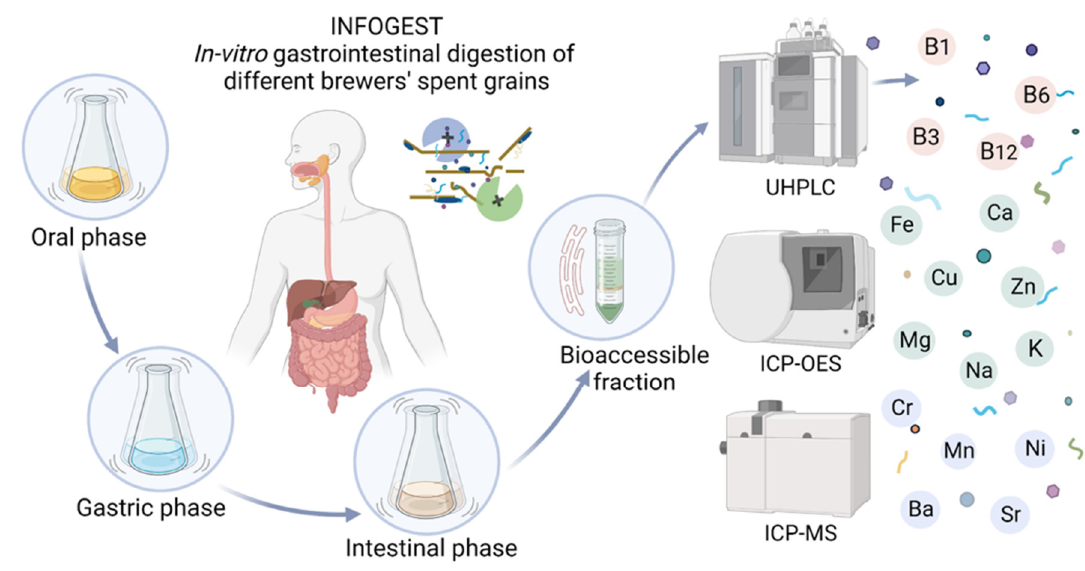
Figure 1. In vitro gastrointestinal digestion of minerals and B group vitamins from different BSG types.